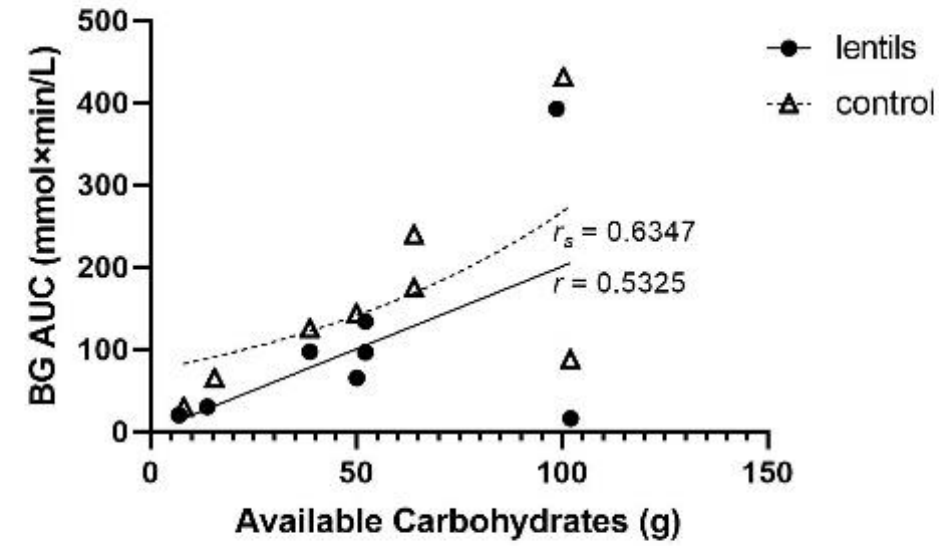
Figure 5. Area under the blood glucose response curve (BG AUC) response at various amounts of available carbohydrates (CHOav) in the lentil treatment or control. A linear model best fit the lentil data ( r = 0.5325; n = 8; ns ), and the control data followed an exponential trend ( r s = 0.6347; n = 8; ns ).